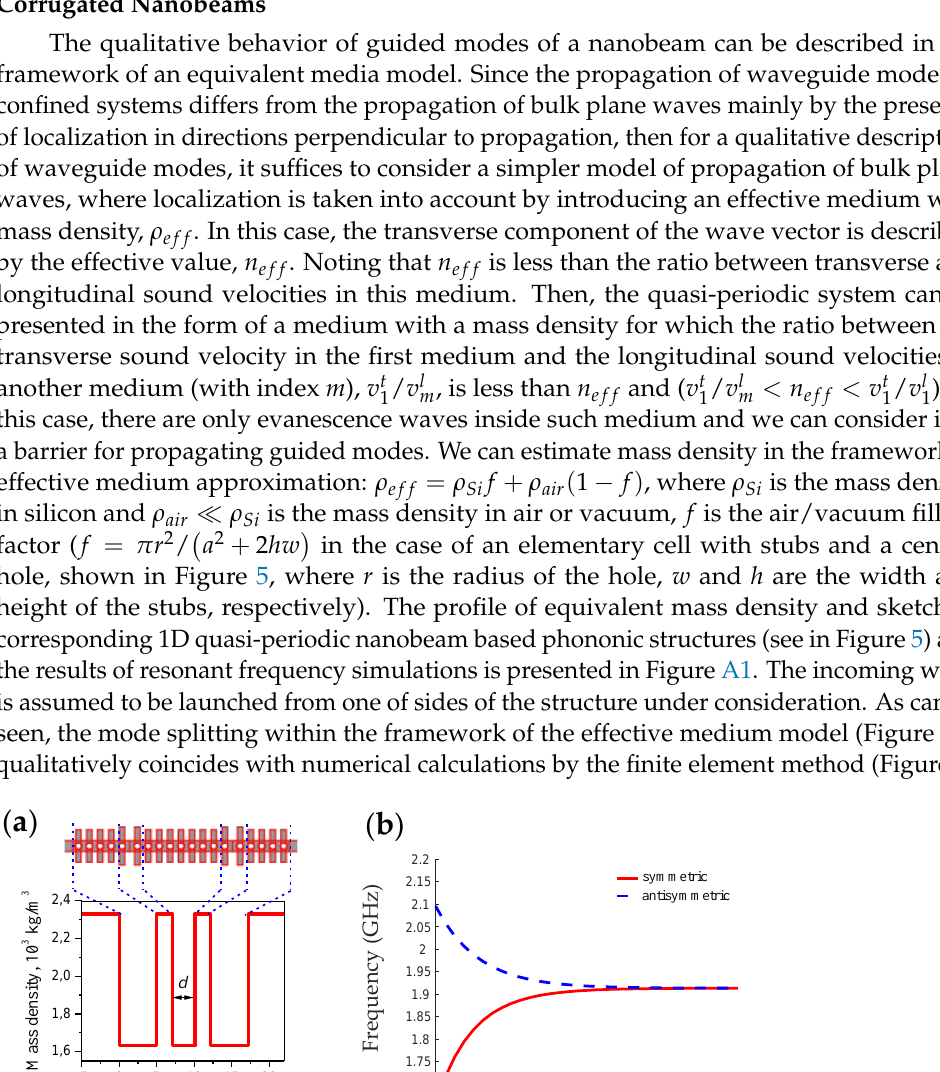
Figure A1. ( a ) The mass density profile of the two cavities linked directly in quasi 1D-periodic phononic crystal of length d . ( b ) Resonant wavelength as a function of the cavities distance d corre- sponding to N cells in panel ( a ) for two cavities linked directly in quasi 1D-periodic phononic crys- tal. ( c ) The mass density profile of the two cavities linked through a straight phononic waveguide of length D . ( d ) Resonant wavelength as function of length D of middle layer (corresponding to a straight phononic beam) in panel ( c ) that connects the two crystals containing the cavities.